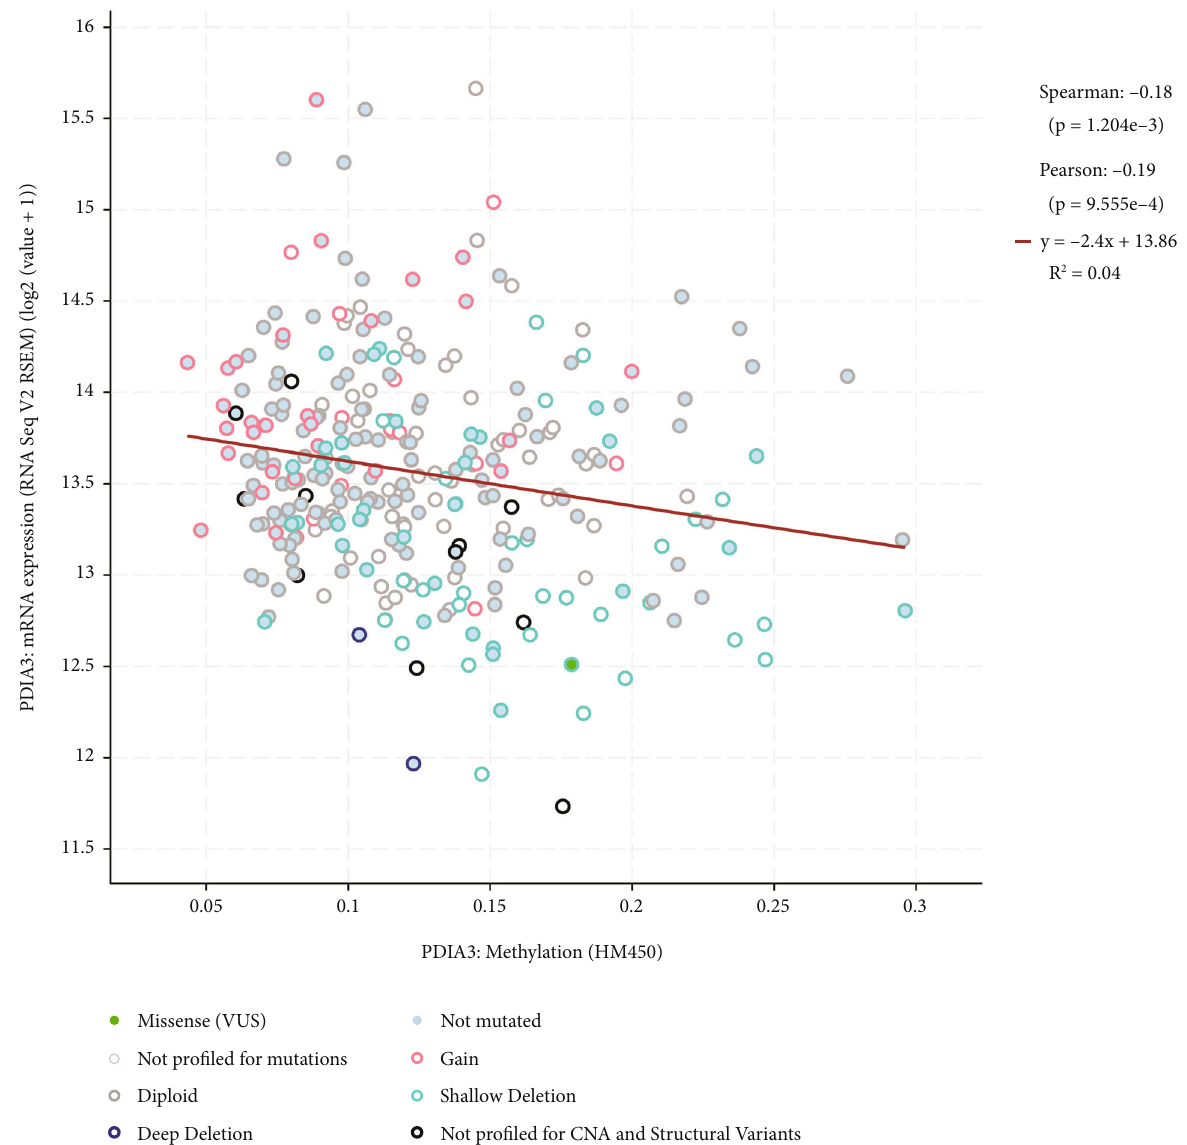
Figure 6: Correlation between PDIA3 expression and DNA The PPI-rich interacting proteins include HSP90B1, ERP27, HSPA5, CALR, STAT3, HLA-A, B2M, CANX, TAPBP, and TAP1 (Figure 8(a)). A total of 10 targeted binding proteins of PDIA3 and 10 genes related to PDIA3 expression were screened out for a series of correlation analysis of the molecular mechanism of PDIA3 in tumors. The PDIA3 expression levels were positively correlated with PPIB ( r = 0 : 73 ; Figure 8(b)), HSP90B1 ( r = 0 : 62 ; Figure 8(c)), P4HB ( r = 0 : 49 ; Figure 8(d)), PDIA4 ( r = 0 : 48 ; Figure 8(e)), HYOU1 ( r = 0 : 51 ; Figure 8(f)), PDIA6 ( r = 0 : 55 ; Figure 8(g)), MANF ( r = 0 : 50 ; Figure 8(h)), CRELD2 ( r = 0 : 52 ; Figure 8(i)), HSPA5 ( r = 0 : 55 ; Figure 8(j)), and MYDGF (C19ORF10) ( r = 0 : 42 ; Figure 8(k); P < 0 : 001 ). The corresponding heat map showed a positive correlation between PDIA3 and the above 10 genes in most cancers (Figure 8(l)).